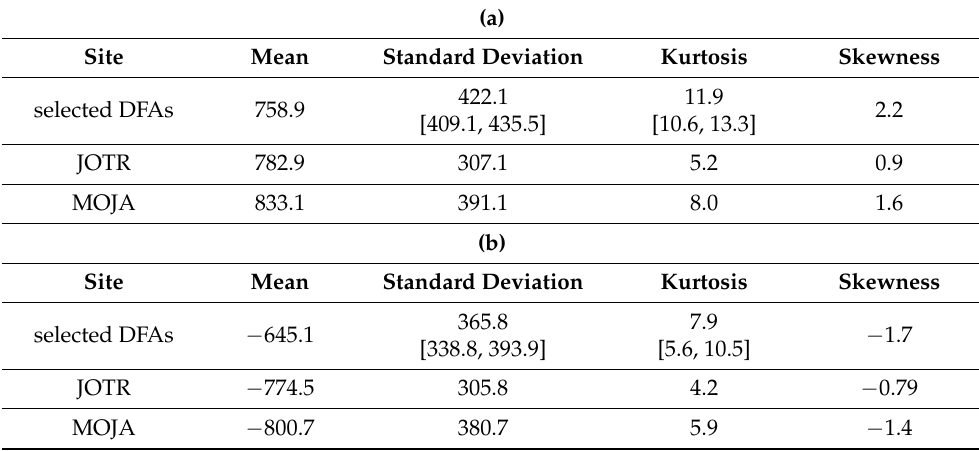
Figure 10. Histogram of positive breakpoint shifts by site. Table 5. ( a ) Positive breakpoint shift distribution statistics by sites. 95% bootstrap confidence intervals are additionally supplied in brackets for DFAs for standard deviation and kurtosis. All statistics are based on scaled NDVI (NDVI × 10,000). ( b ) Negative breakpoint shift distribution statistics by sites. 95% bootstrap confidence intervals are additionally supplied in brackets for DFAs for standard deviation and kurtosis. All statistics are based on scaled NDVI (NDVI ×